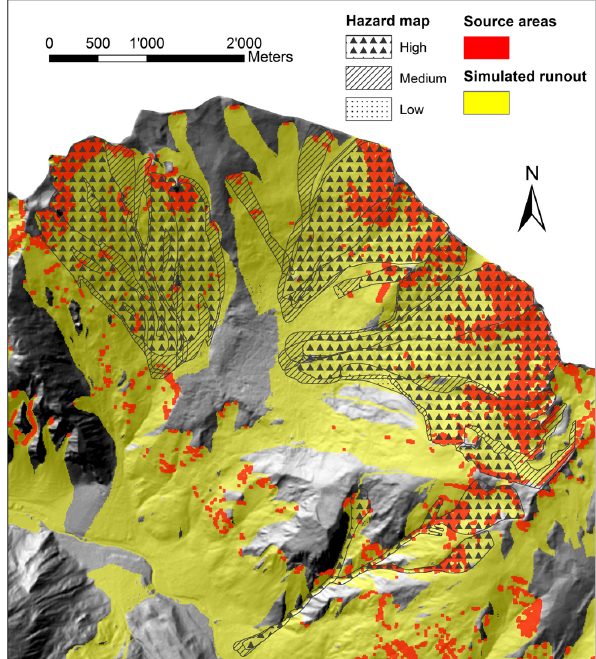
Fig. 16. Results of avalanche zonation with Flow-R in regards to the events inventory in the Verbier area (see location in Fig. 8).